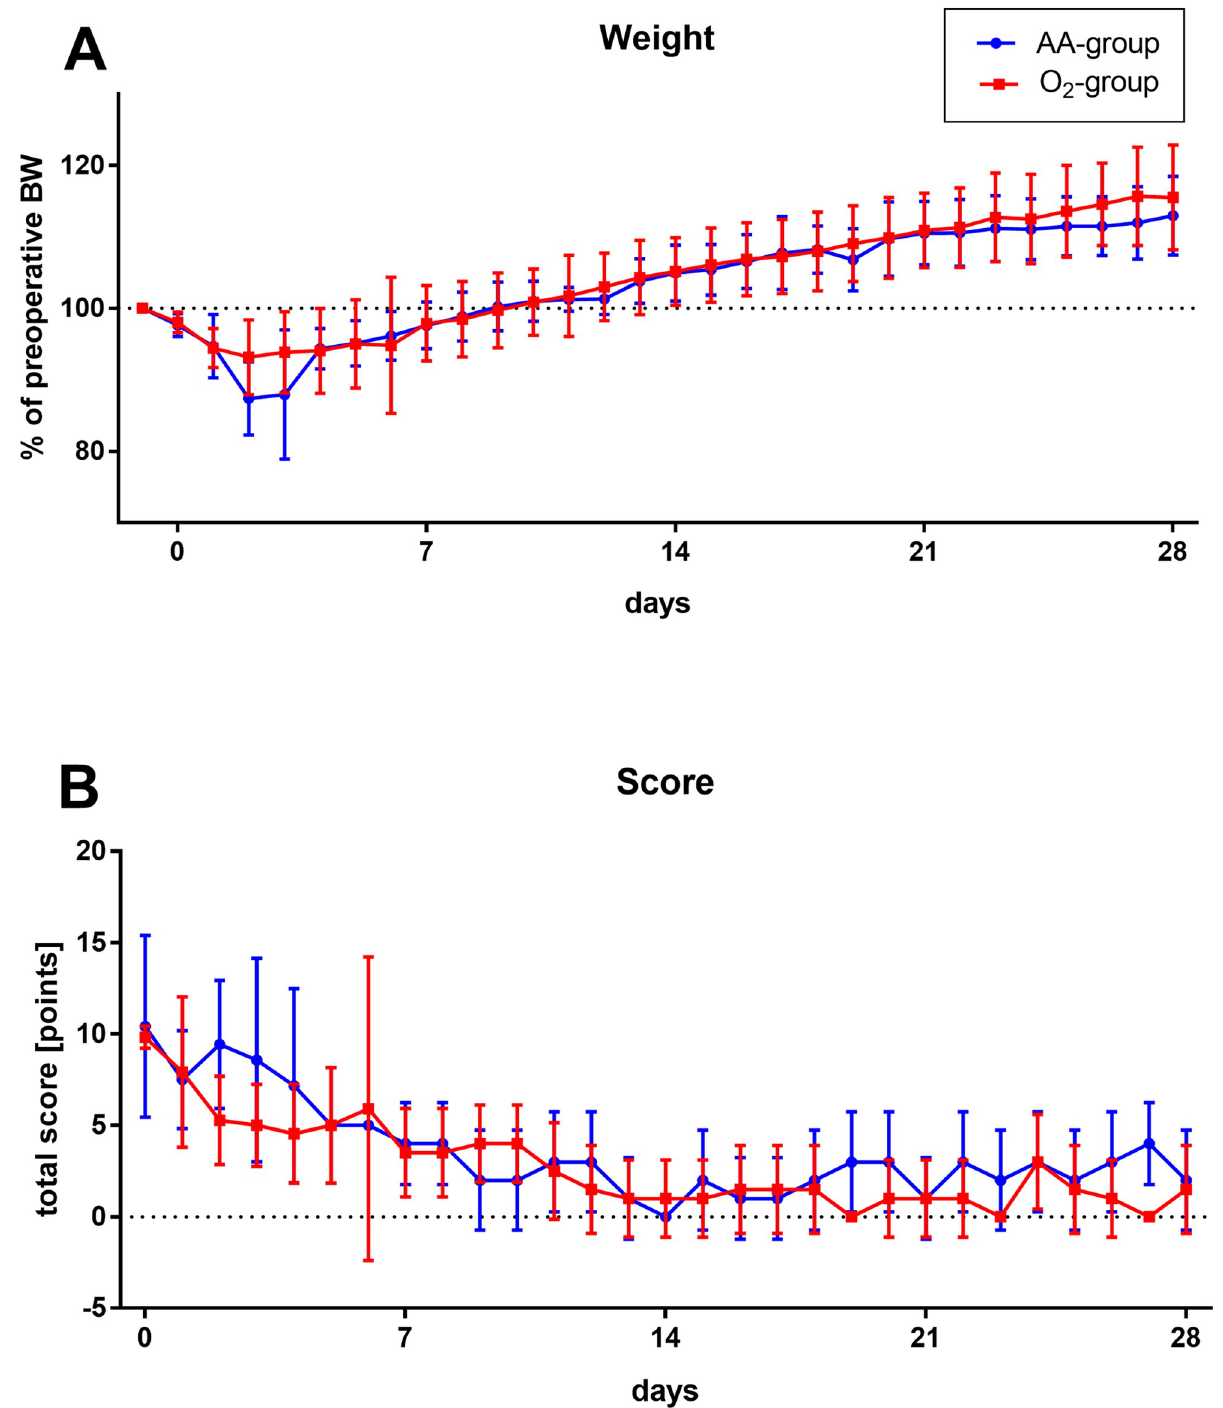
Fig 3. Postoperative weight and score development of male rats during the follow-up period of 28 days after KX anaesthesia with (O 2 group) or without (AA group) additional intra- and postoperative oxygen insufflation. Course of (A) postoperative, in relation to preoperative body weight (BW) and (B) the postoperative score values illustrated for ambient air (AA) and oxygen (O 2 ) group. A score value of altogether 5 to 9 points was defined as low, 10 to 19 points as medium and equal or greater than 20 points as high distress. There are no significant group differences in weight ( p = 0.521) or score values ( p = 0.259). However, the average weight in rats that only received ambient air tends to be slightly lower on the second and third postoperative day and the score value from the second to the fourth day slightly higher than in animals with additional oxygen.